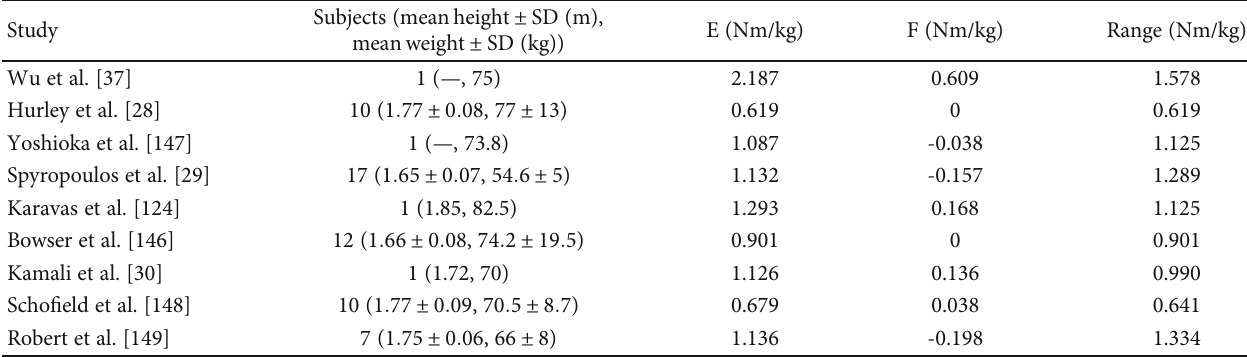
Table 11: Overview over the experimental results of knee moment for